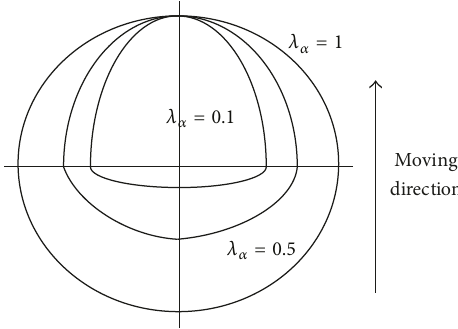
Figure 1: Schematic diagram of different anisotropic coefficients.